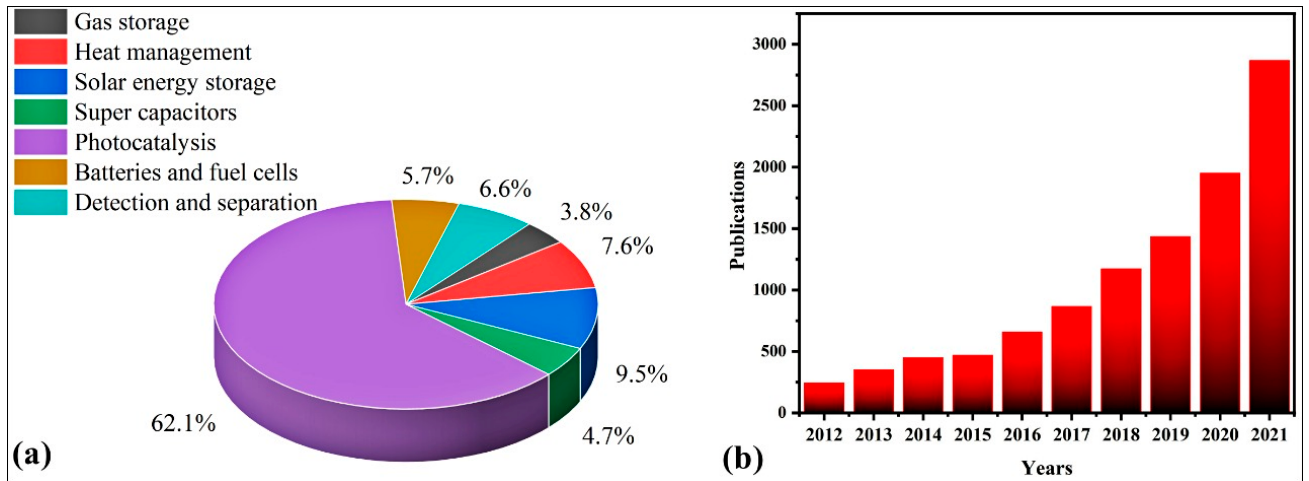
Figure 1. ( a ) Diverse environmental applications of carbon-based NMs (Scopus searched) ( b ) Pub- lications from 2012 to 2021 searched on dated 4 April 2022 employing keyword “carbon-based nanoparticles + environment